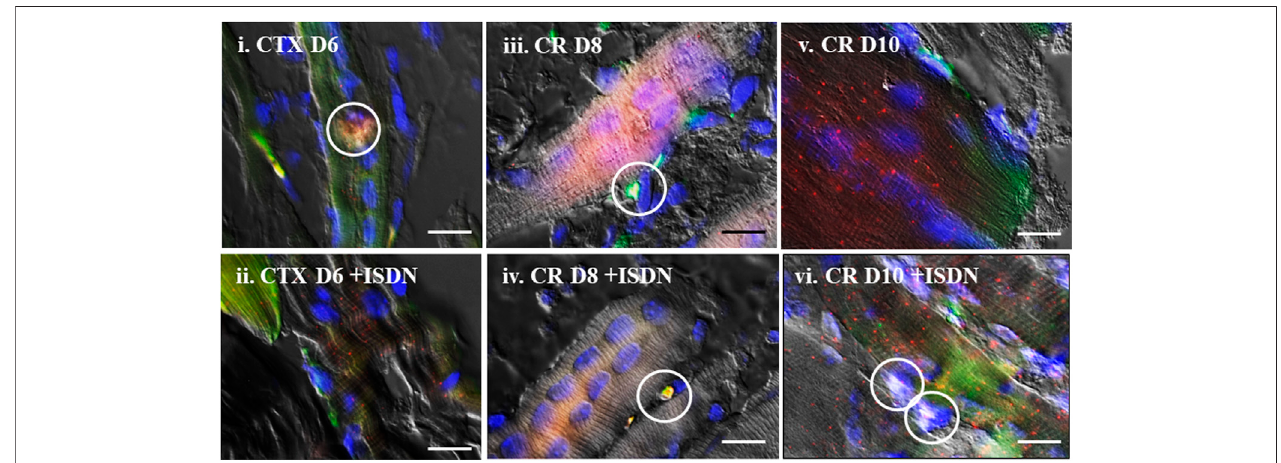
FIGURE 3 | Colocalization of expression. Representative in situ hybridization (ISH) images merged with differential interference contrast (DIC) of the same fi eld, showing Sema3A (green) and S100B (red) mRNA expression after cardiotoxin injury (day 6 (D6)) (i,ii) and after muscle-crush injury (D8, iii,iv, and D10, v,vi ) without pretreatment (i,iii,v) and with 2 days of ISDN pretreatment (ii,iv,vi) . Areas of Sema3A (green) and S100B (red) mRNA expression colocalized with P75 protein (white fl uorescence) in terminal Schwann cells are indicated by white circles. Nuclei are counterstained with 4 ′ ,6-diamidino-2-phenylindole (blue) in all fi elds. Bars indicate 10